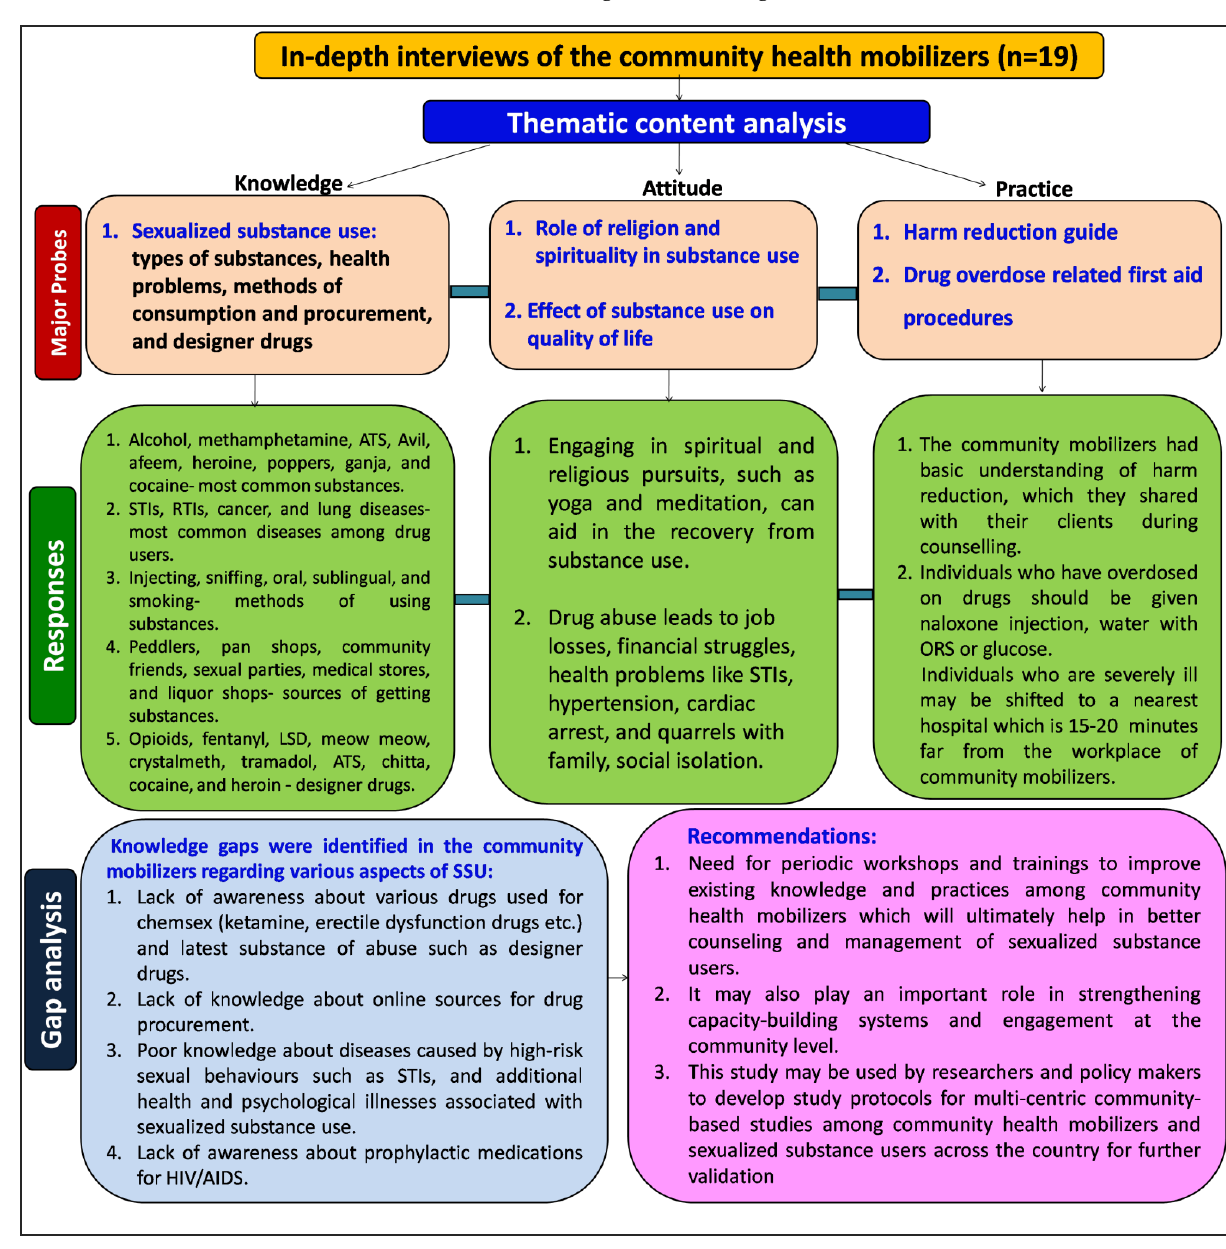
Figure 2. Overview of the